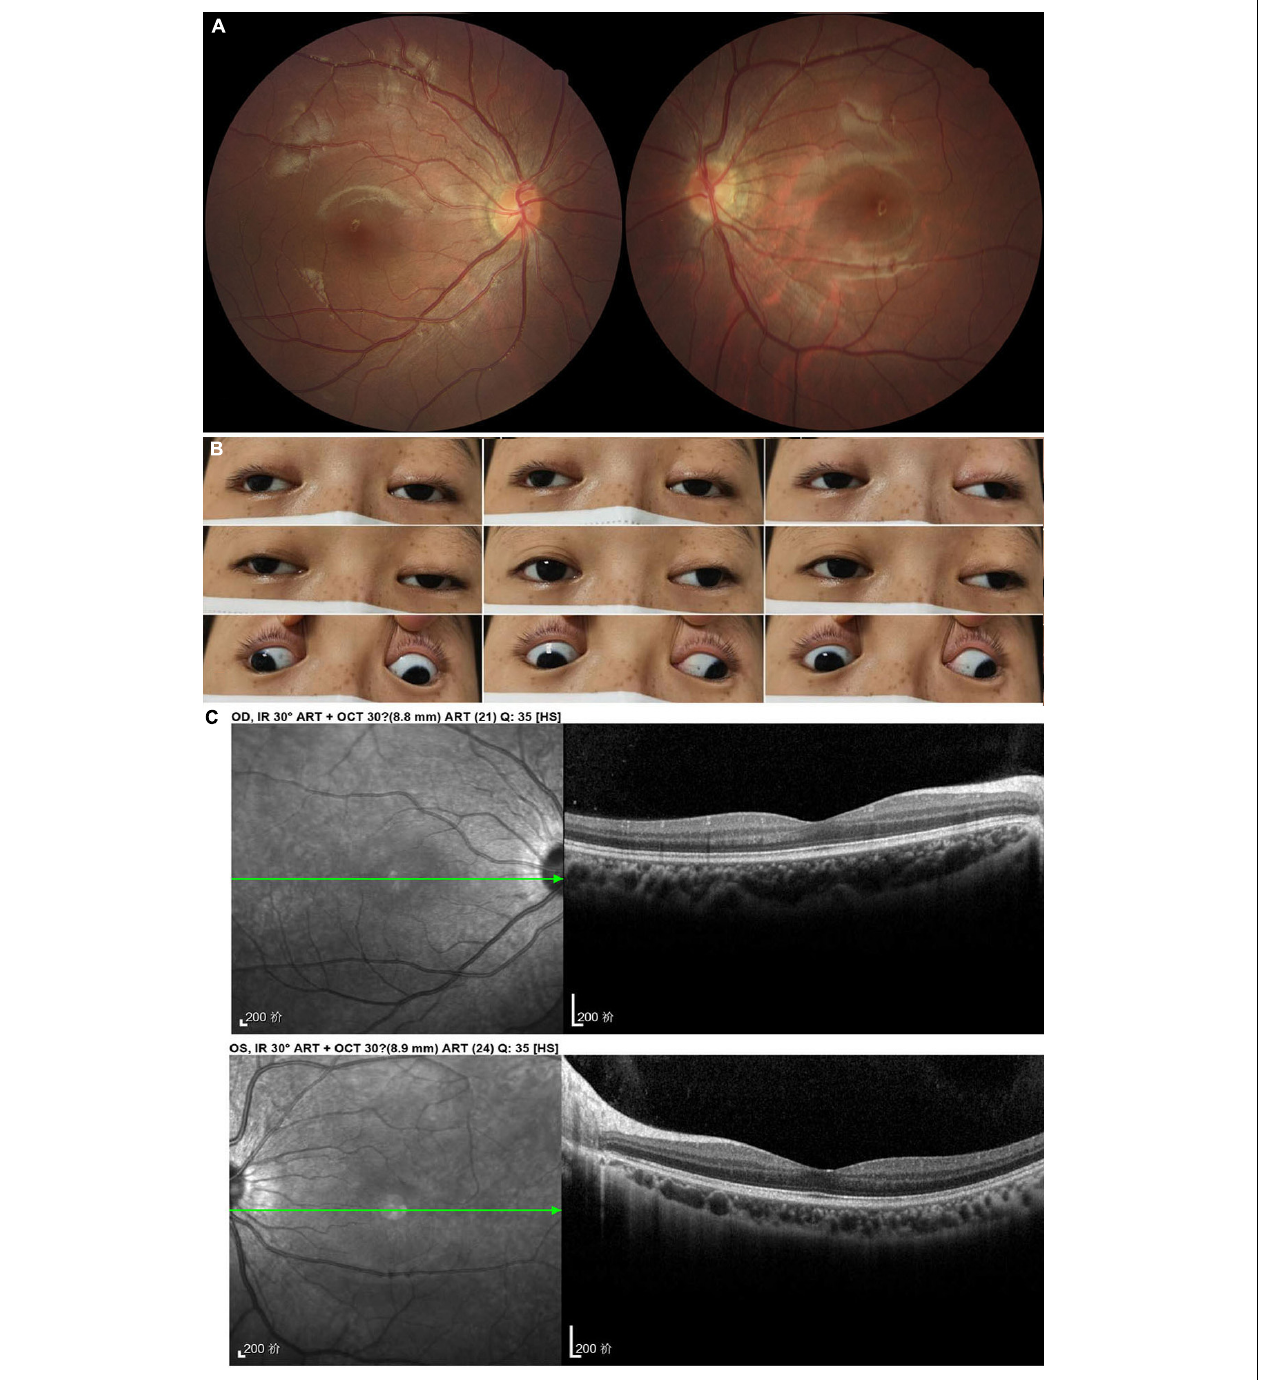
FIGURE 4 | Accessory examinations of case 4. (A) Fundus photos showed normal optic disc and retina bilaterally. (B) Nine cardinal eye positions revealed adduction, elevation, and depression were moderately reduced bilaterally, and abduction was slightly reduced in the right eye and almost full in the left eye. (C) OCT showed normal retina thickness and macular structure